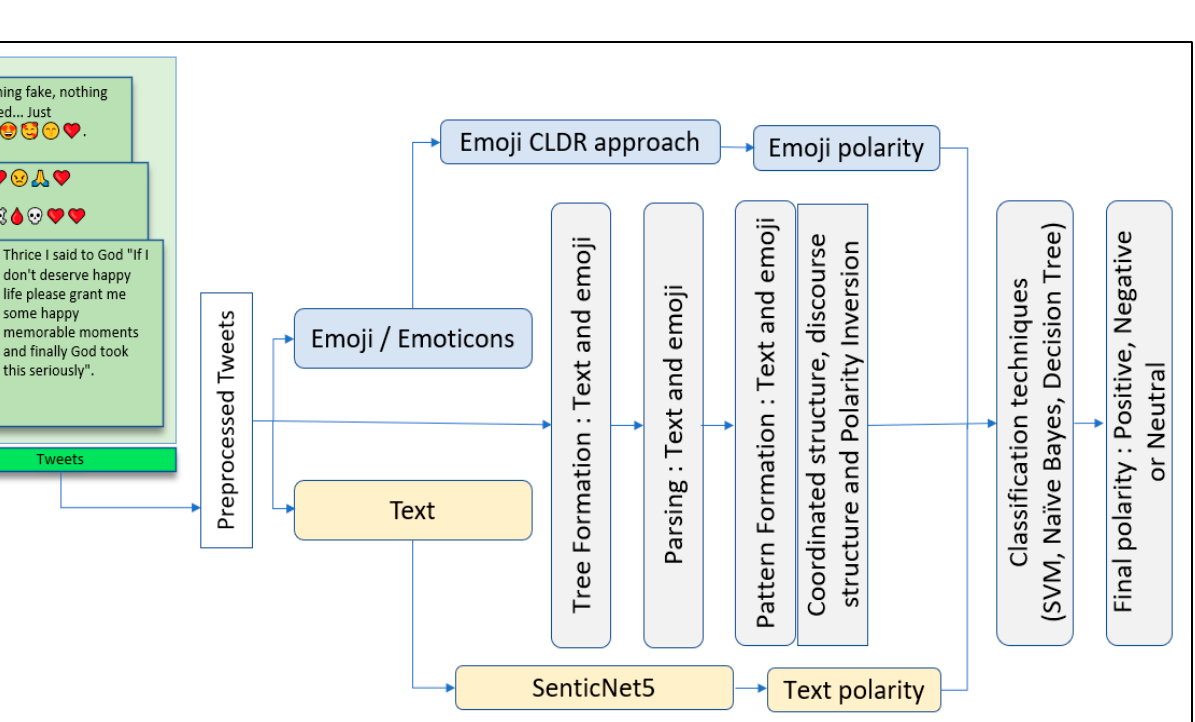
Figure 1. Proposed framework.